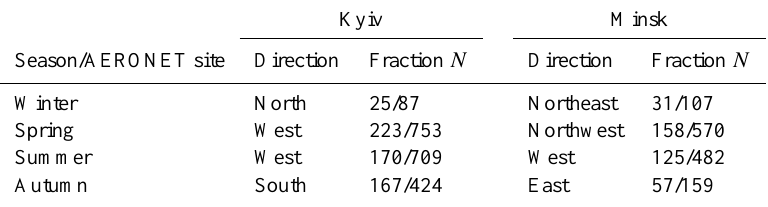
Table 2. The most prevailing seasonal trajectory for the Kyiv and Minsk sites calculated using the back trajectories and cluster analysis.